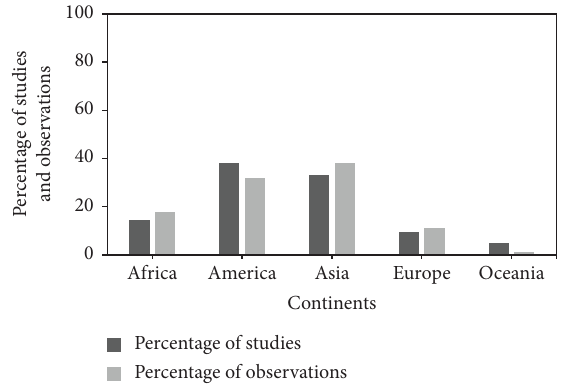
Figure 3: Spatial scale of